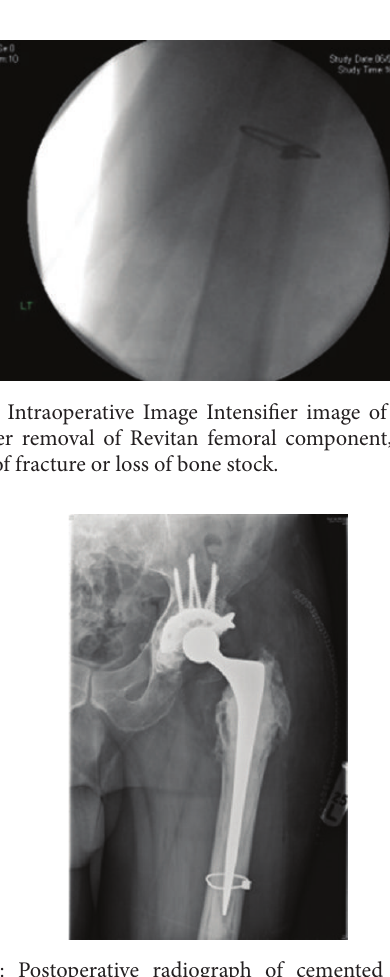
Figure 2: Intraoperative image, intensifier image of custom made instrument contacting tip of Revitan femoral component.